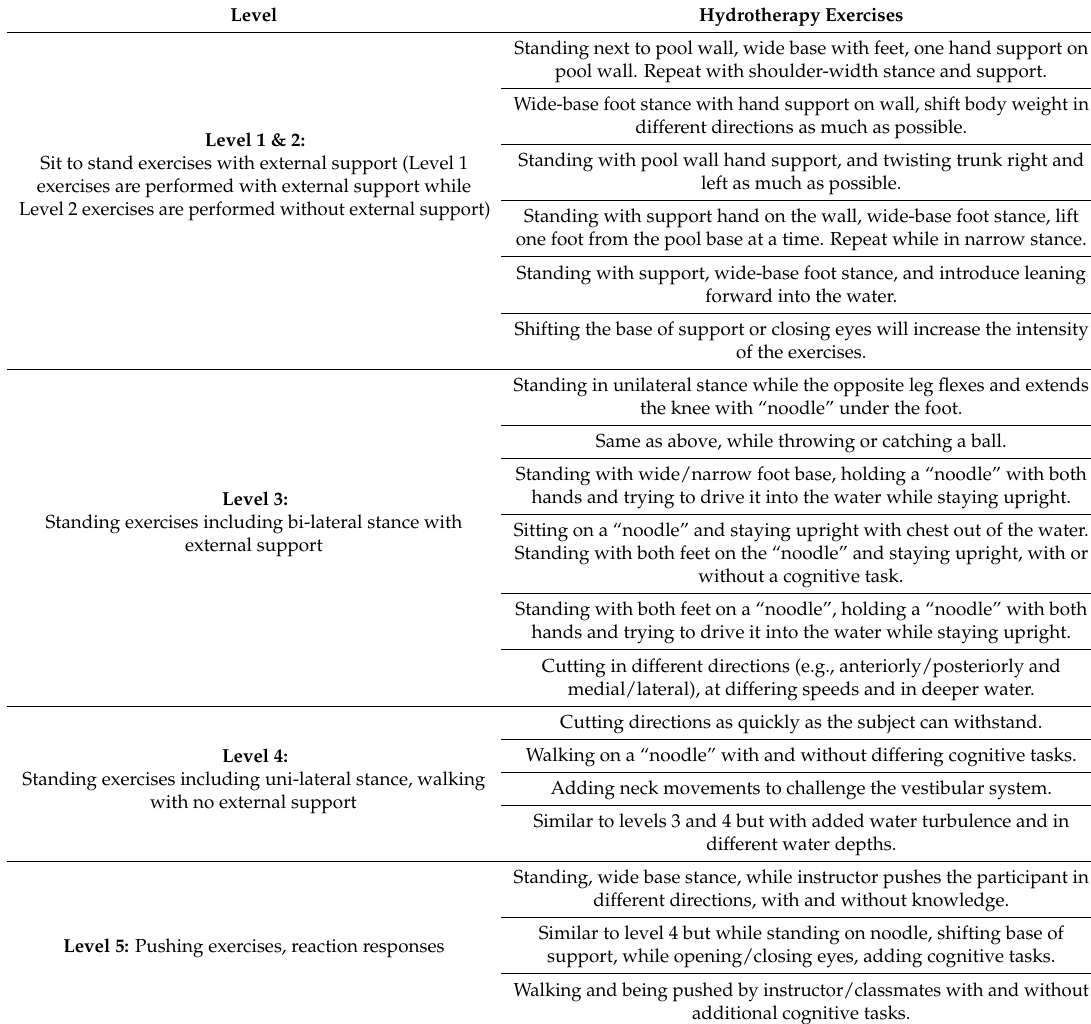
Table 1. An example of various levels of hydrotherapy-based balance training exercises for geriatric populations based on adaptations from Oddson et al.